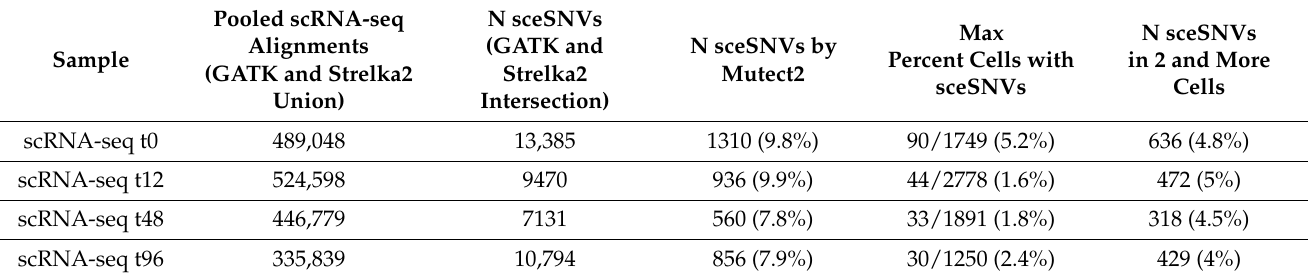
Table 2. The number of SNVs transcriptome-wise, and percent cells with scSNVs.